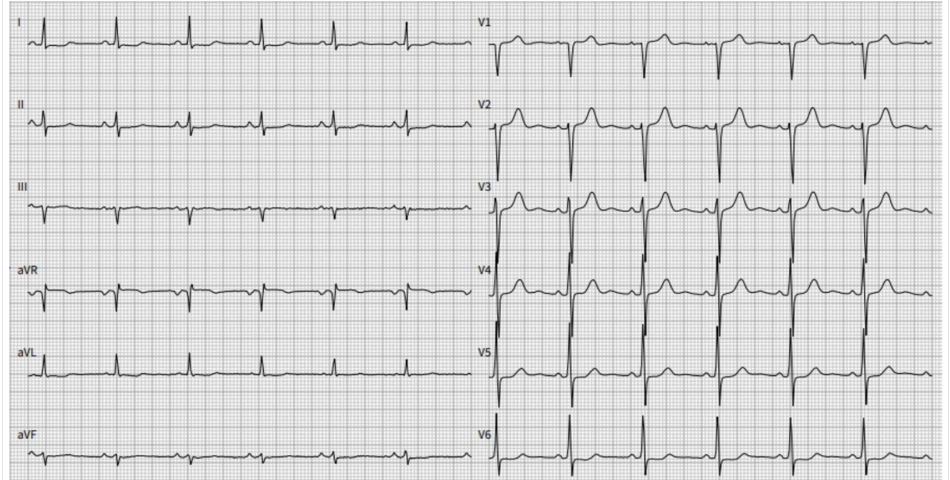
Figure 2. A twelve-lead electrocardiogram (ECG) demonstrated sinus rhythm with a normal rate. Poor R wave progression and low-voltage QRS were observed in standard leads. PR interval 139 ms, Qtc interval 424